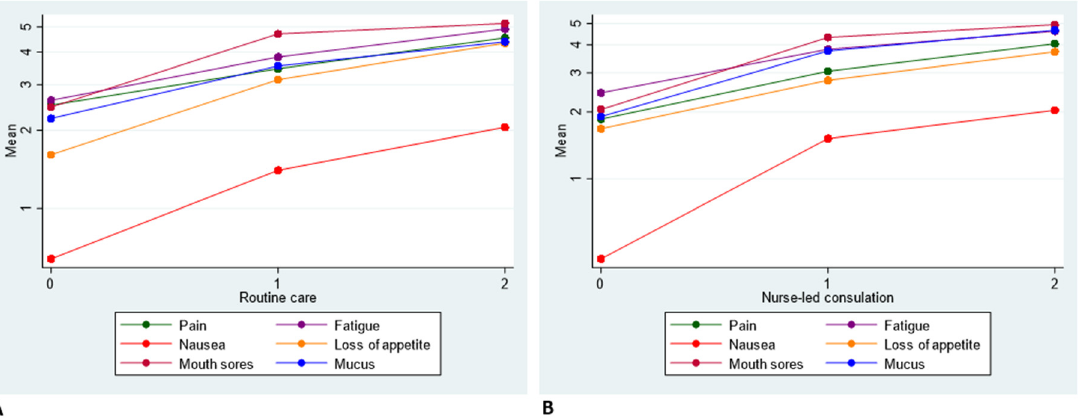
Figure 3. Change in symptoms in the routine care ( A ) and consultation group ( B ) at three different times during radiotherapy treatement.